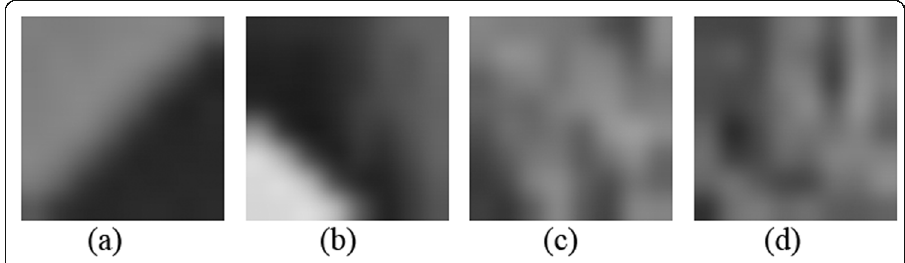
Fig. 1 Local main orientation comparison of edge patches and texture